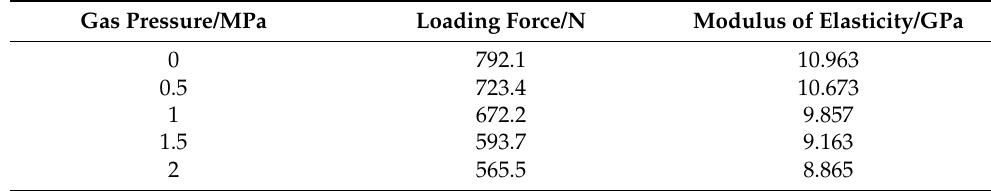
Table 3. Table of relation between different gas pressure and mechanical properties of coal